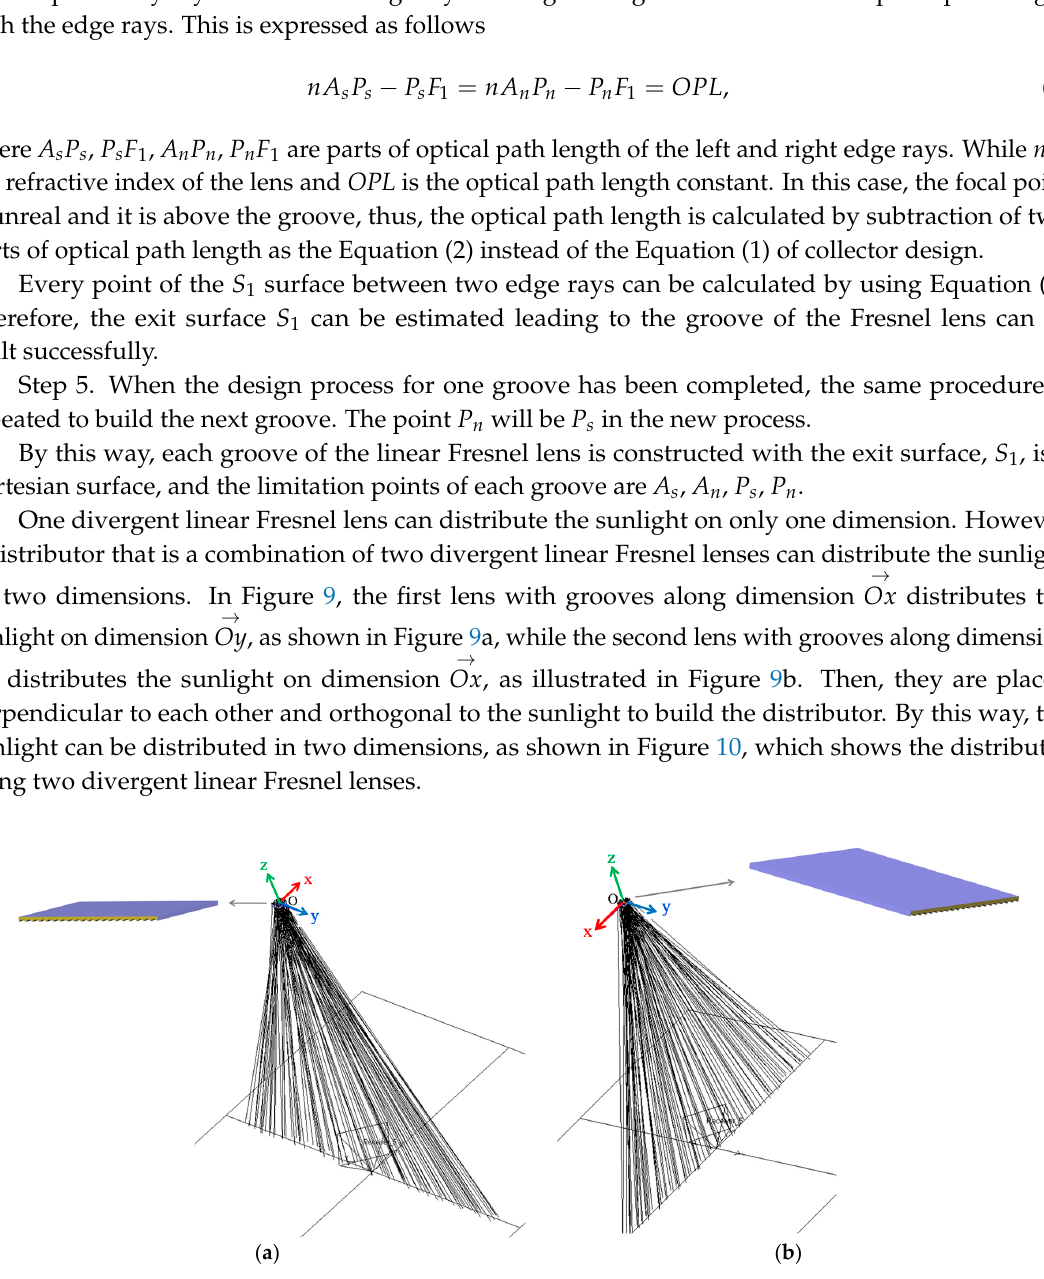
Figure 9. The divergent linear Fresnel lenses distribute the sunlight on one dimension with ( a ) the lens with the grooves along Ox ; ( b ) the lens with the grooves along Oy